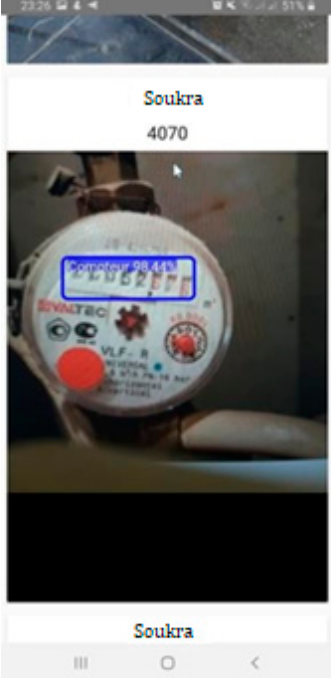
Figure 17. The show uploads